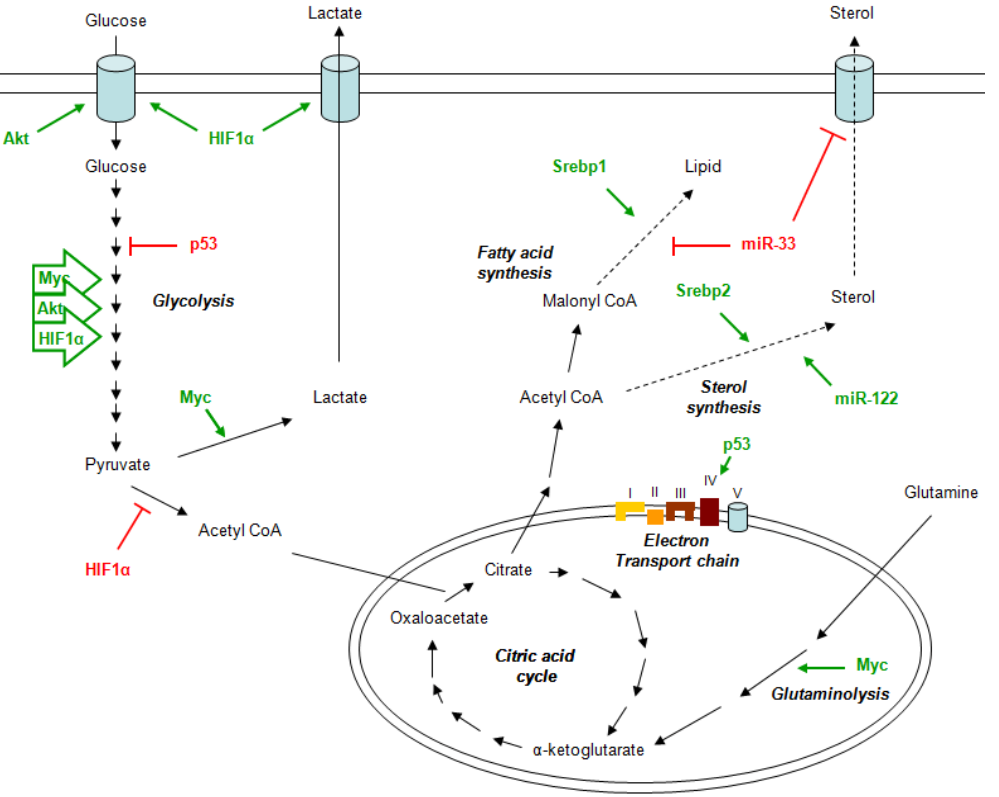
Figure 1. The role of oncogenes, tumor suppressors and microRNAs in cancer